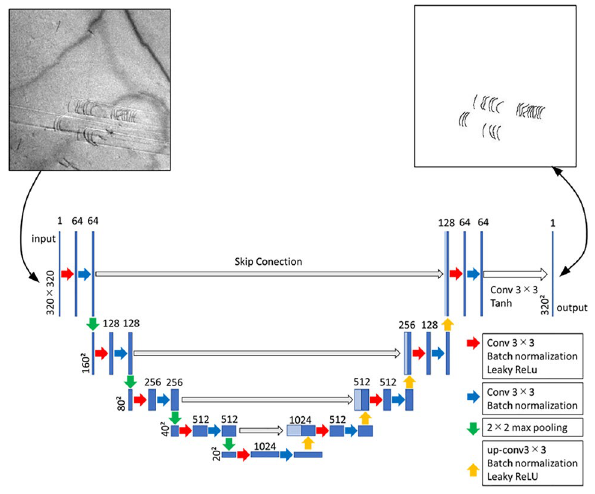
Figure 6. U-net architecture (for 320 × 320 pixels). Each blue square corresponds to a multichannel feature map. The light blue squares represent copied feature maps. The number of channels is shown at the top of individual boxes, and the size is shown in the lower left corner of them. Each arrow represents each operation.